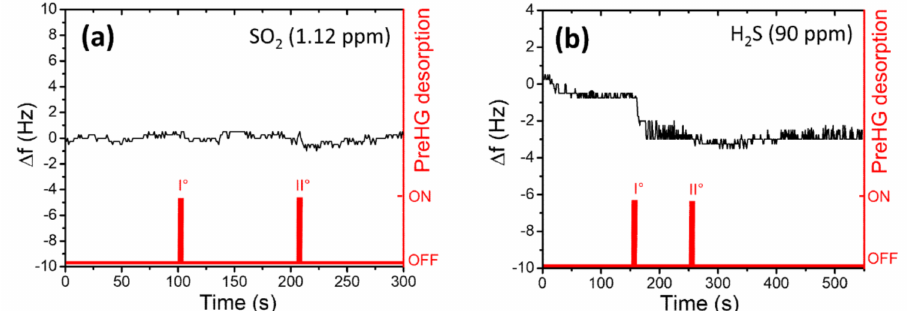
Figure 14. QCM frequency shift, after a PreHG exposition of 10 min, at 1.12 ppm of SO 2 ( a ) and to 90 ppm of H 2 S ( b